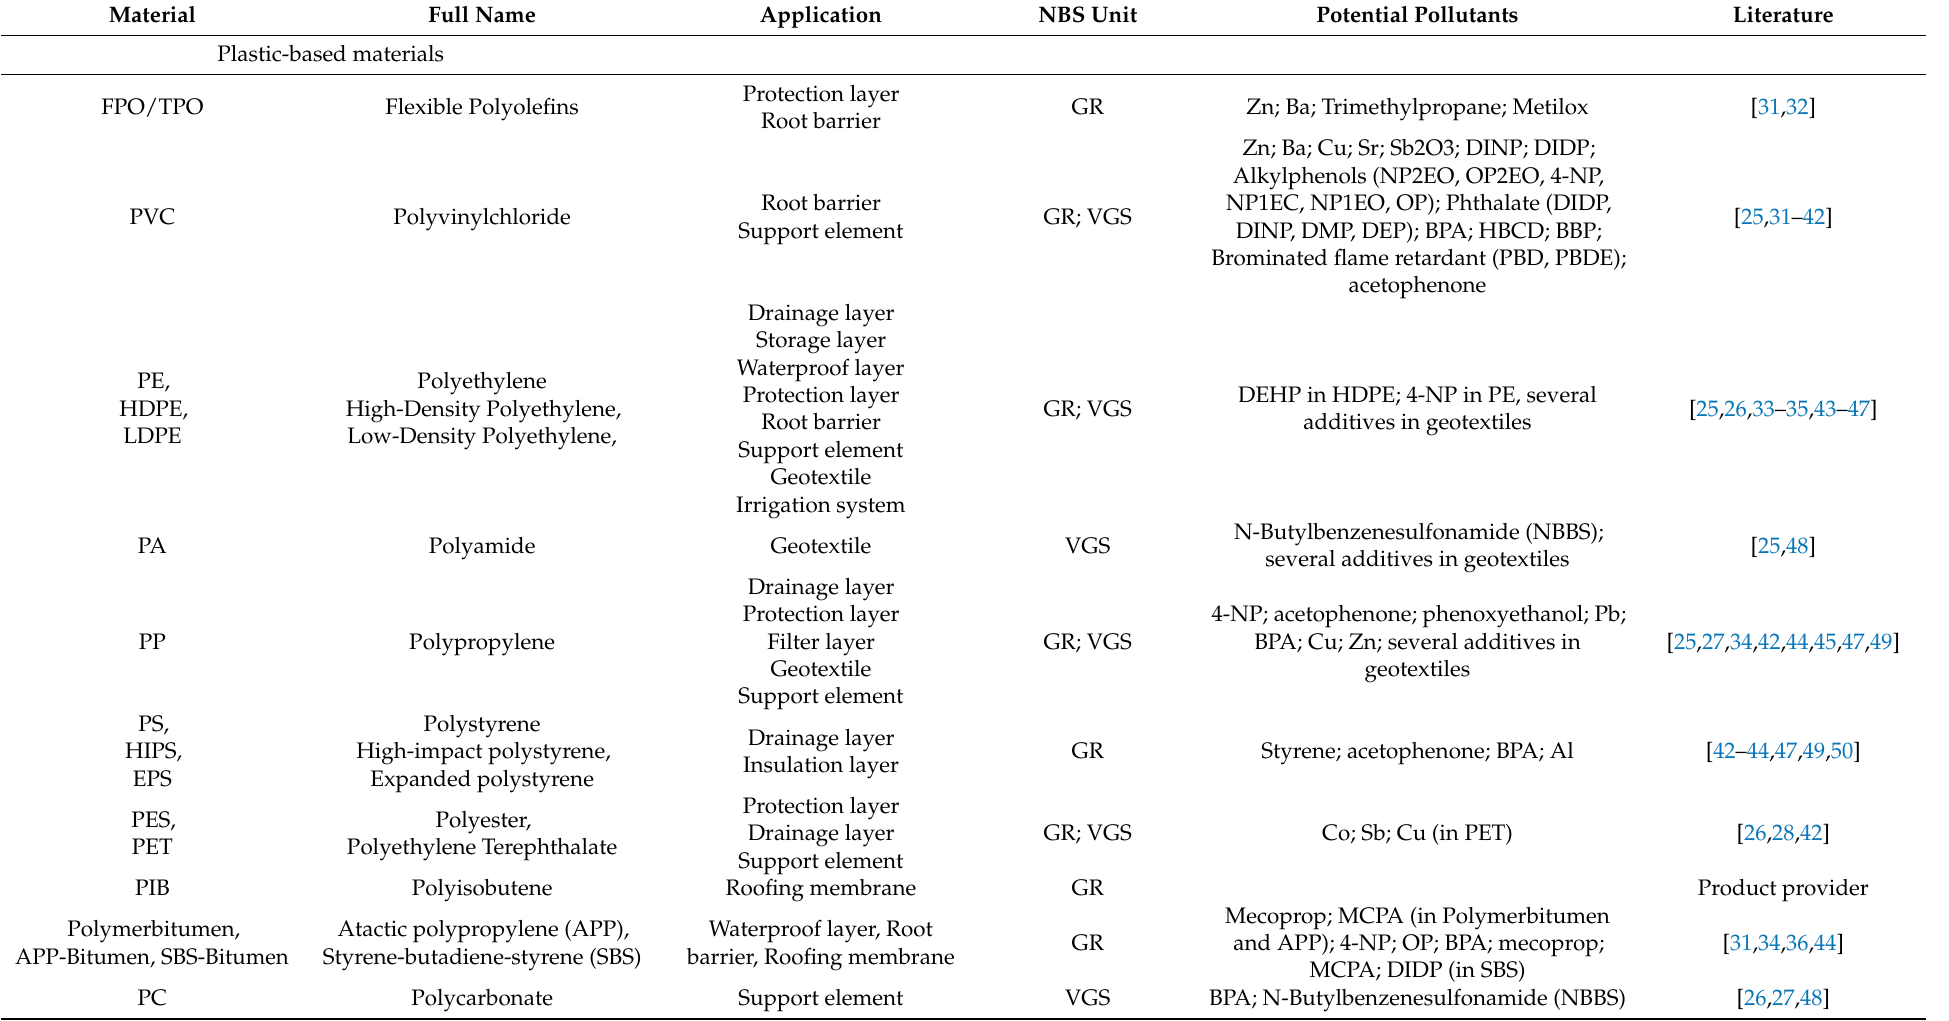
Table 2. Materials used in green roofs and vertical greenery systems and potential